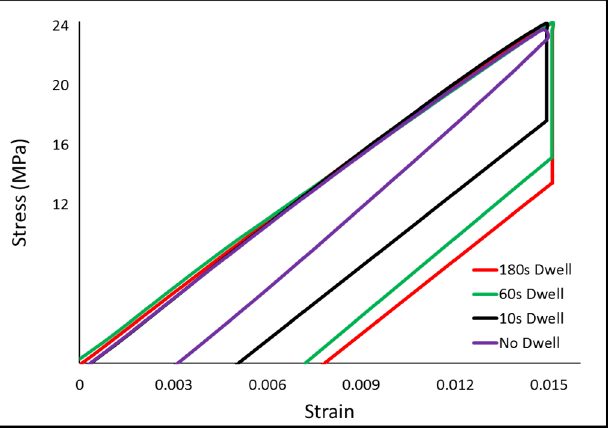
Figure 18. The hysteresis loops for SAC305 joints cycled at various dwellings with 24 MPa stress level.